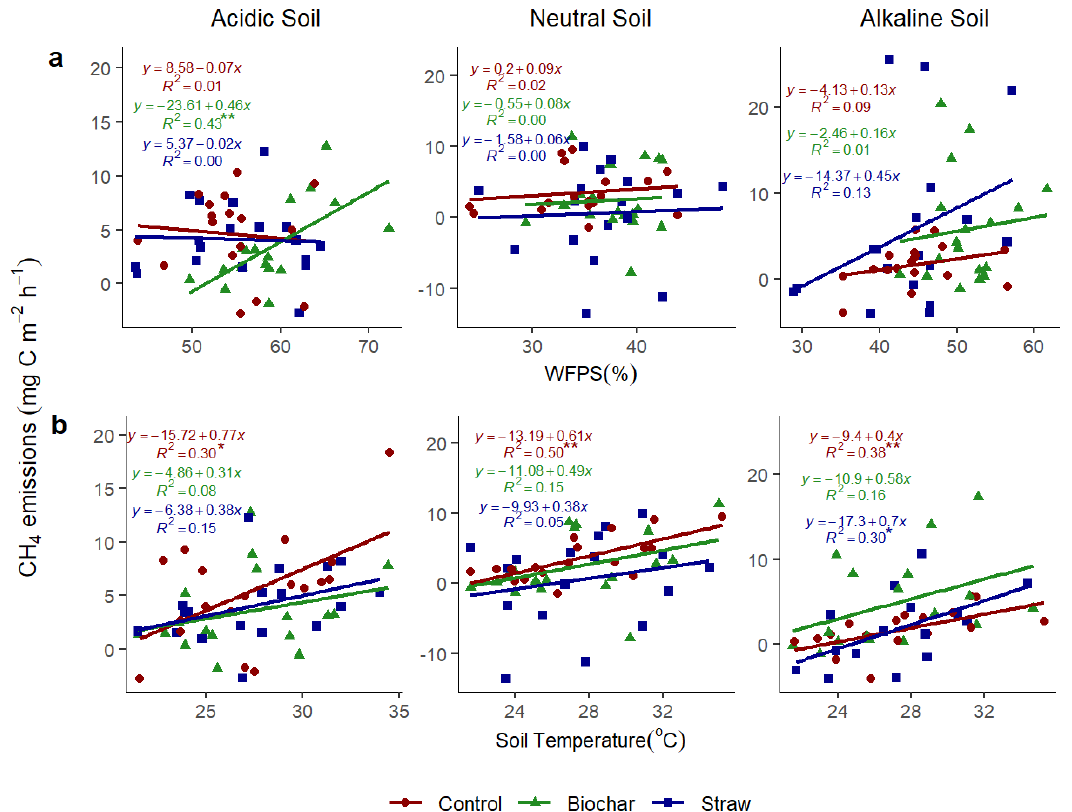
Figure 9. The relationships between CH 4 emissions and ( a ) soil WFPS and ( b ) soil temperature in soils with different pH treated with biochar and straw averaged over 18 days. Note: (*) shows that the strength of relationship is significant at p -value ≤ 0.05, and (**) shows that the strength of relationship is significant at p -value ≤ 0.01. The axes of different natural soil pH are on different scales.